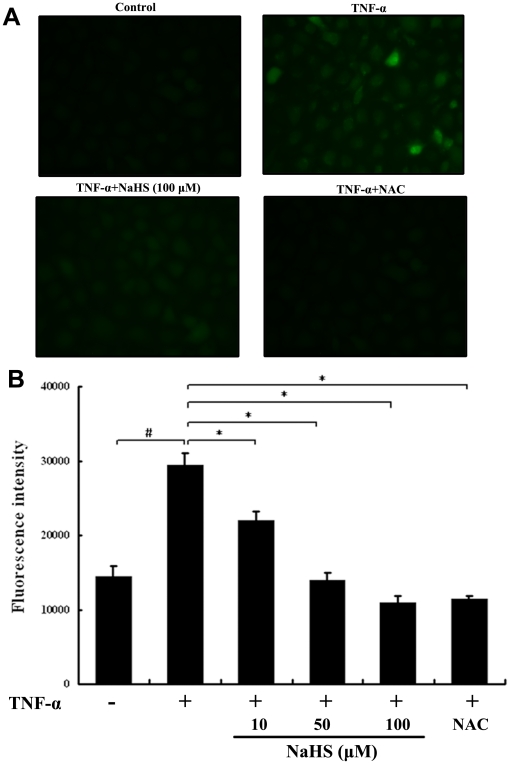
NaHS inhibited TNF-α-induced intracellular ROS generation.HUVEC were incubated with NaHS or NAC for 30 min, and then stimulated with TNF-α (10 ng/ml) for 1 h. (A) Pictures are representative fields detected by fluorescence microscope. NaHS and NAC concentration were 100 µM and 5 mM, respectively. (B) Quantitation of intracellular ROS was determined by fluorescence spectrophotometer. NAC concentration was 5 mM. #
P<0.05 compared with unstimulated cells, *P<0.05, **P<0.01 compared with TNF-α-stimulated cells. Data are the mean ±S.E.M of results from at least three independent experiments, each performed in duplicate.